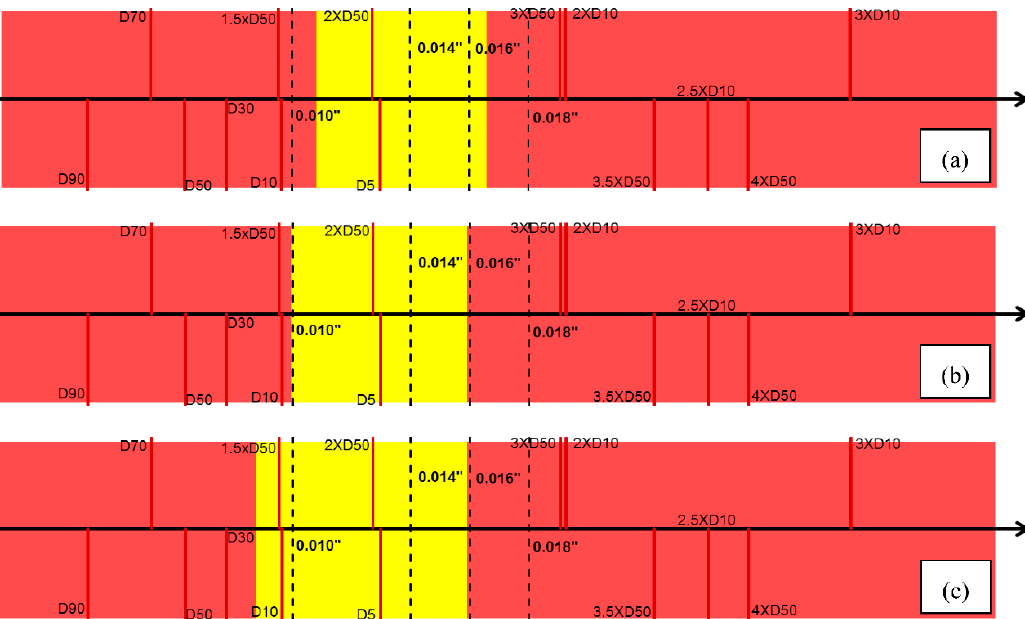
Figure 13. TLS of DC ‐ II in the normal condition for SPF 120 ( a ), SPF 168 ( b ), and SPF 216 ( c ). Energies 2020 , 13 , x FOR PEER REVIEW